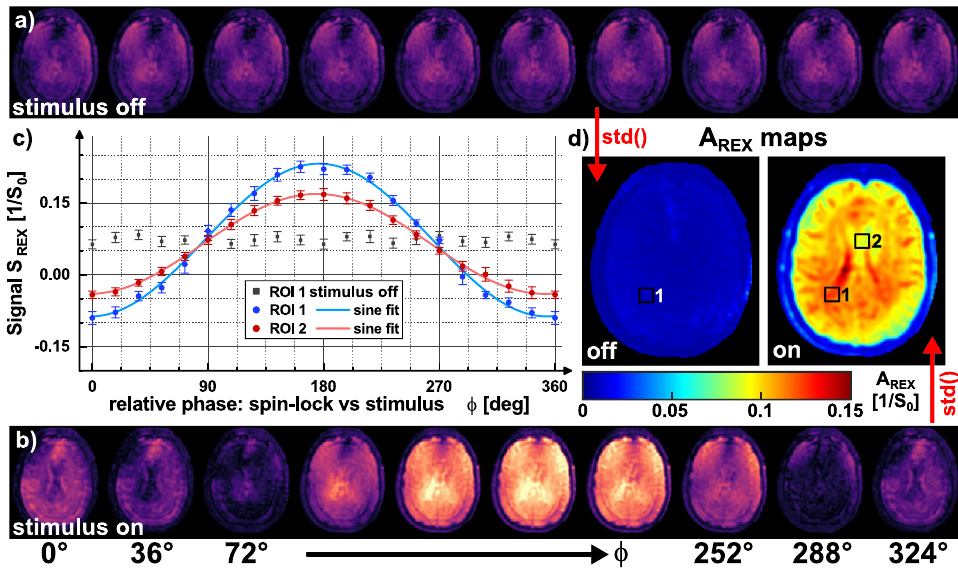
Figure 7. Proof-of-concept results of tREX measurements in vivo in human brain using B-SL. ( a , b ) REX weighted magnitude images (S REX ) for 10 different relative phases between the spin-lock pulse and the magnetic field oscillation. REX weighted images with 20 relative phases ϕ were acquired in a Δz = 10 mm offcenter slice (f SL = f stim = 50 Hz, (cid:31) B stim 0 = 50 nT) and control measurements were carried out (stimulus off). In ( c ), the signal intensities of the ROI based evaluation are plotted against the relative phase. As can be seen in the A